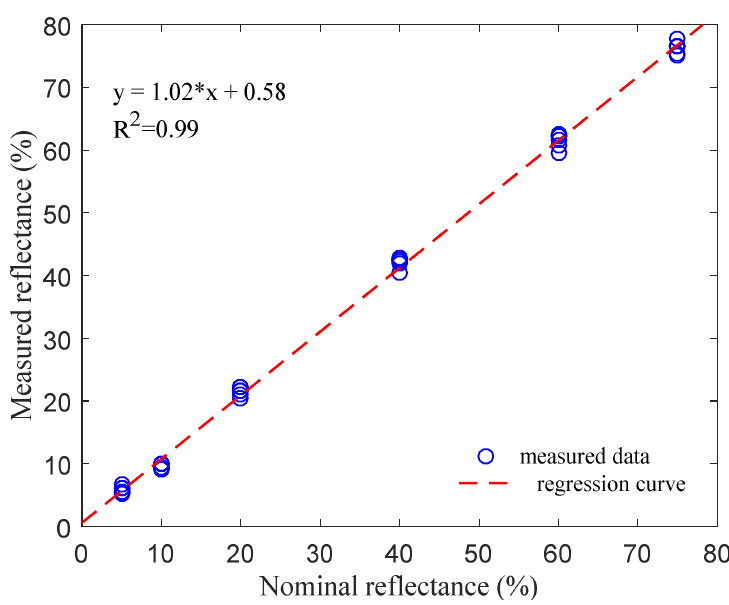
Figure 12. Linear regression results of measured and nominal values for 730 and 810 nm wavebands.